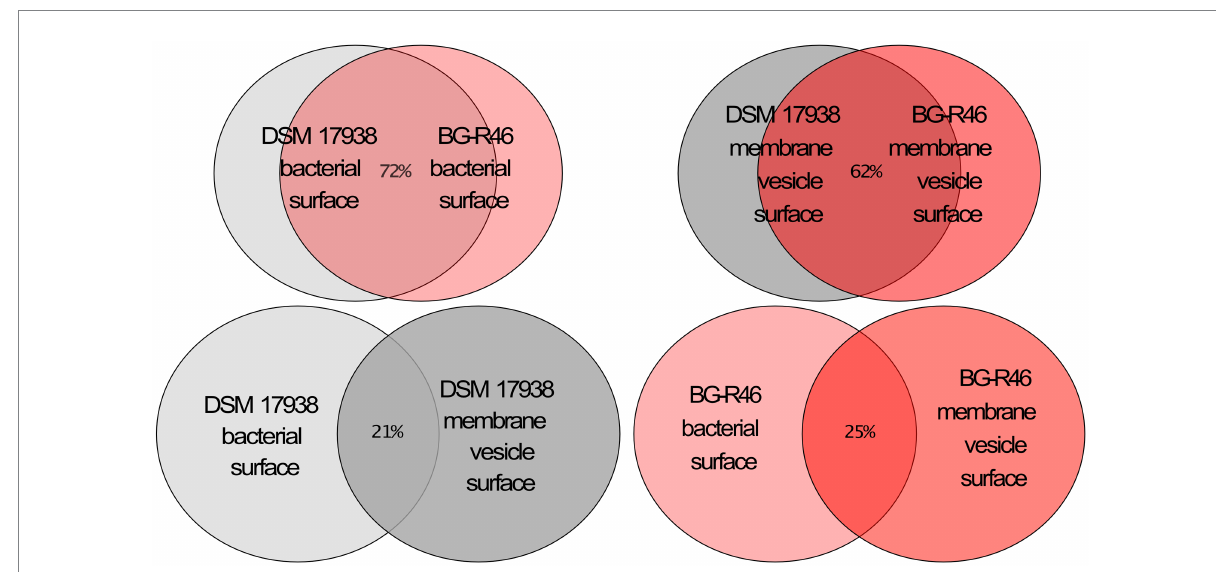
FIGURE 3 Venn diagram displaying a comparison of the 100 most abundant proteins on the bacterial surfaces and the membrane vesicle surfaces of DSM 17938 and BG-R46. The proteomic analysis was performed by using a trypsin mediated surface shaving, Lipid-based Protein Immobilization method. The color key is gray = DSM 17938 and red = BG-R46, light color indicate bacterial surface, dark color indicate membrane vesicle